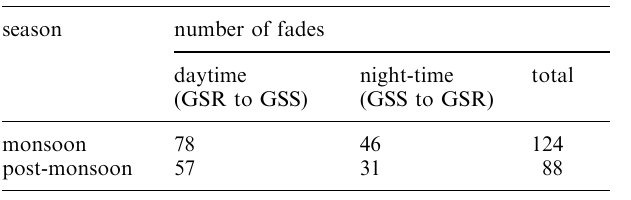
Table 1. Number of fades during day and night-time (GSR: ground sunrise; GSS: ground sunset) season